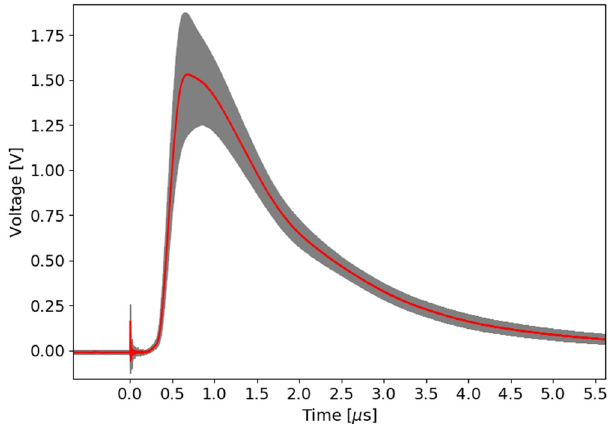
Fig. 6 Faraday cup measurements. Averaged TOF (time-of- fl ight) signal for all shots at the CH-BN target (red) together with standard deviation (gray). The beginning of the signal is very stable, while the fl ux fl uctuates